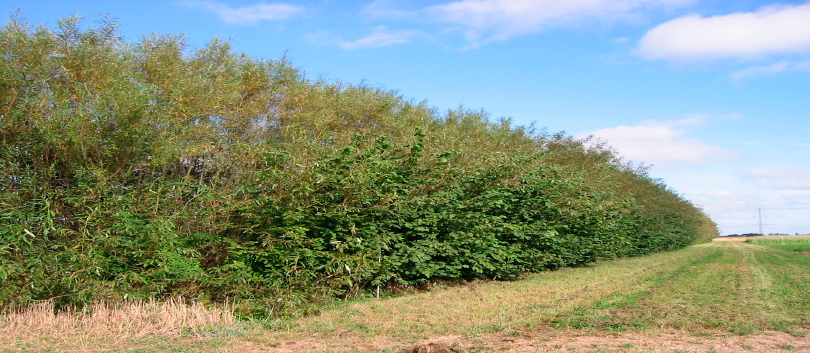
Figure 2. Short rotation woody crop (SRWC) belts in the experimental farm Taastrup, Denmark.